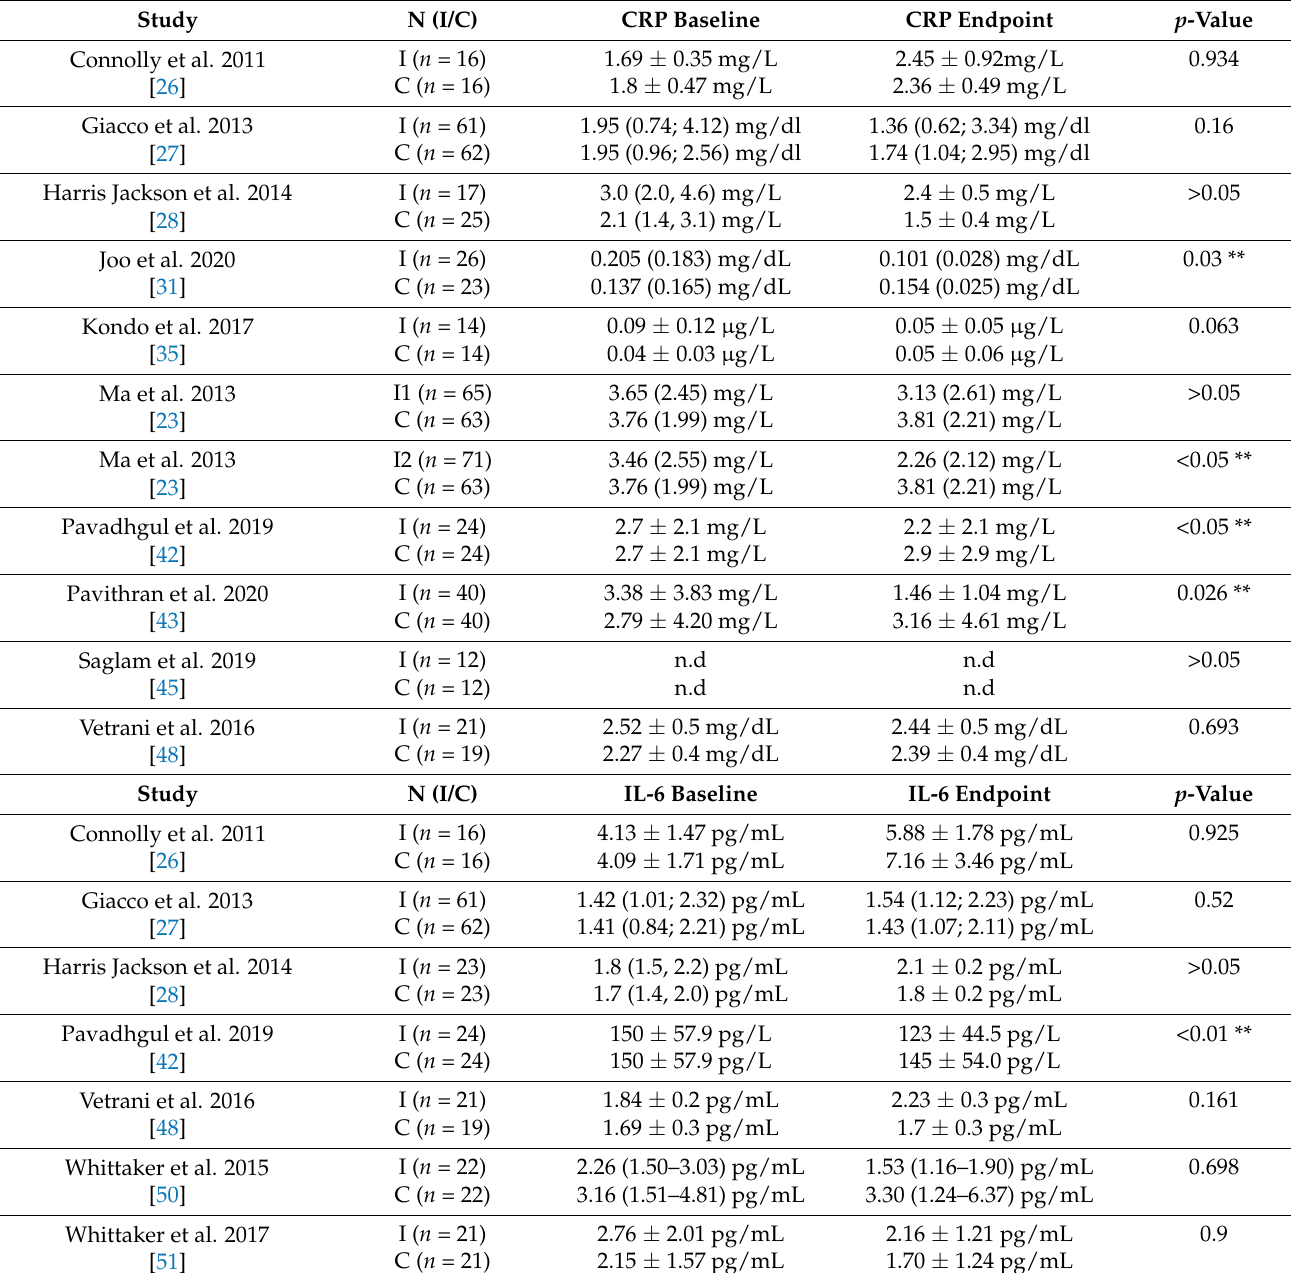
Table 4. Effect of whole grain consumption on inflammatory markers in individuals with pre- existing